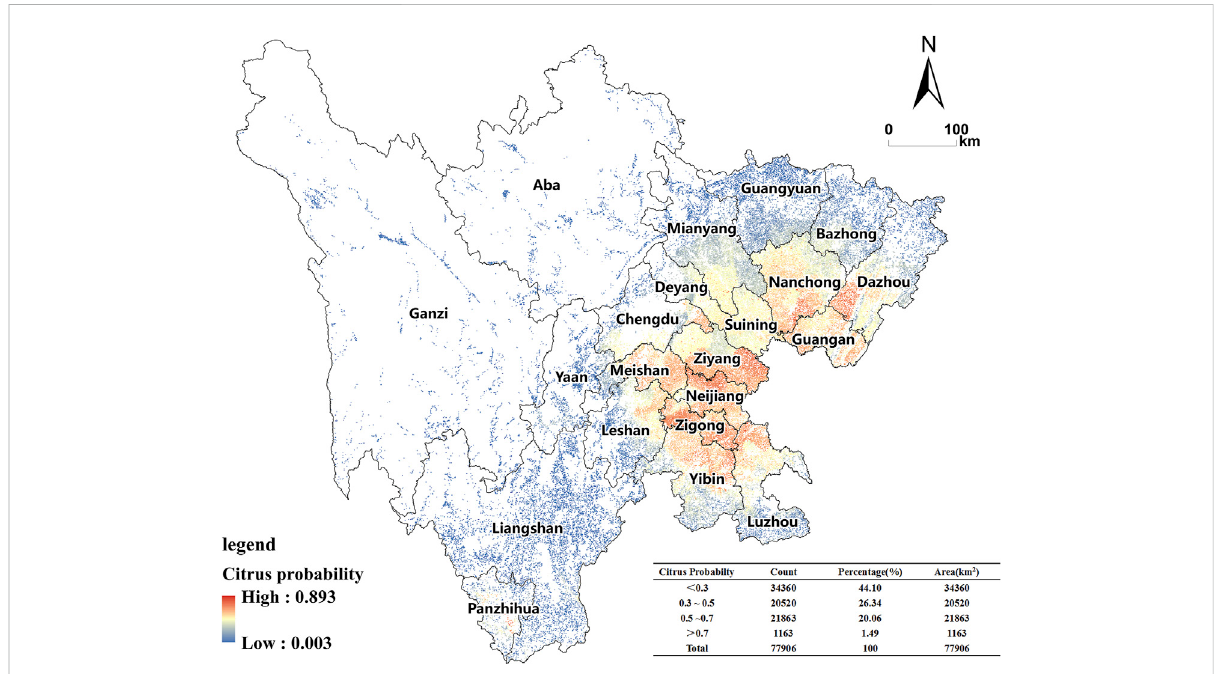
FIGURE 6 Suitable distribution probability of citrus in sichuan based on natural and human